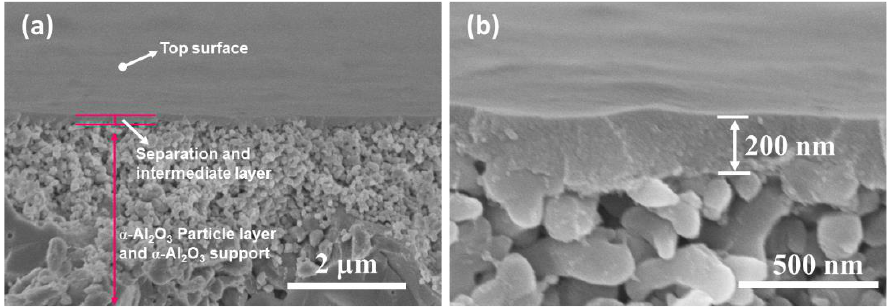
Figure 20. SEM images of the top surface and cross-section of pre-cross-linked AHPCS-derived membranes: ( a ) low and ( b ) high magnification. Reprinted from [73] with permission from Elsevier.